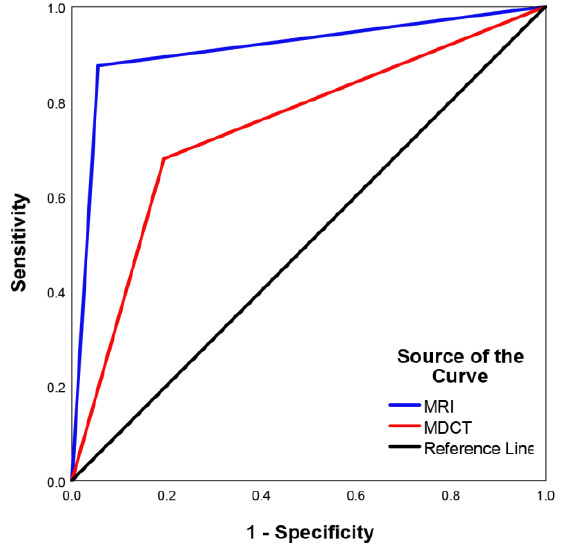
Figure 2. Receiver operating characteristic curve of MRI and MDCT for discriminating BC recurrence and benign treatment-related diseases.